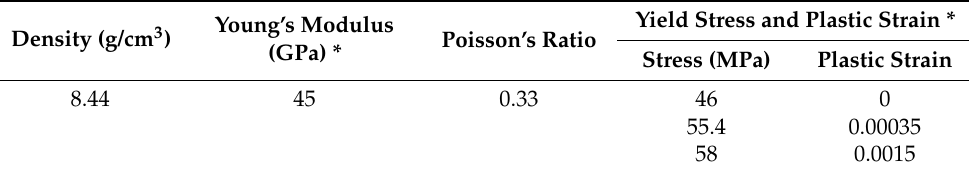
Figure 8. A typical example, experimentally realizing the top panel deformation from bidirectional S0R90 part: ( a ) 3D scanned result of the selected points. ( b ) Summary of the designed positions, the displacement of the selected points along x ‐ and z ‐ axis. ( c ) Displacement functions realized from ( b ), ∆ X(X) and ∆ Z(X), applied to the FE ‐ model to describe the final deformed model. Table 3. Material information for IN625 used for ABAQUS